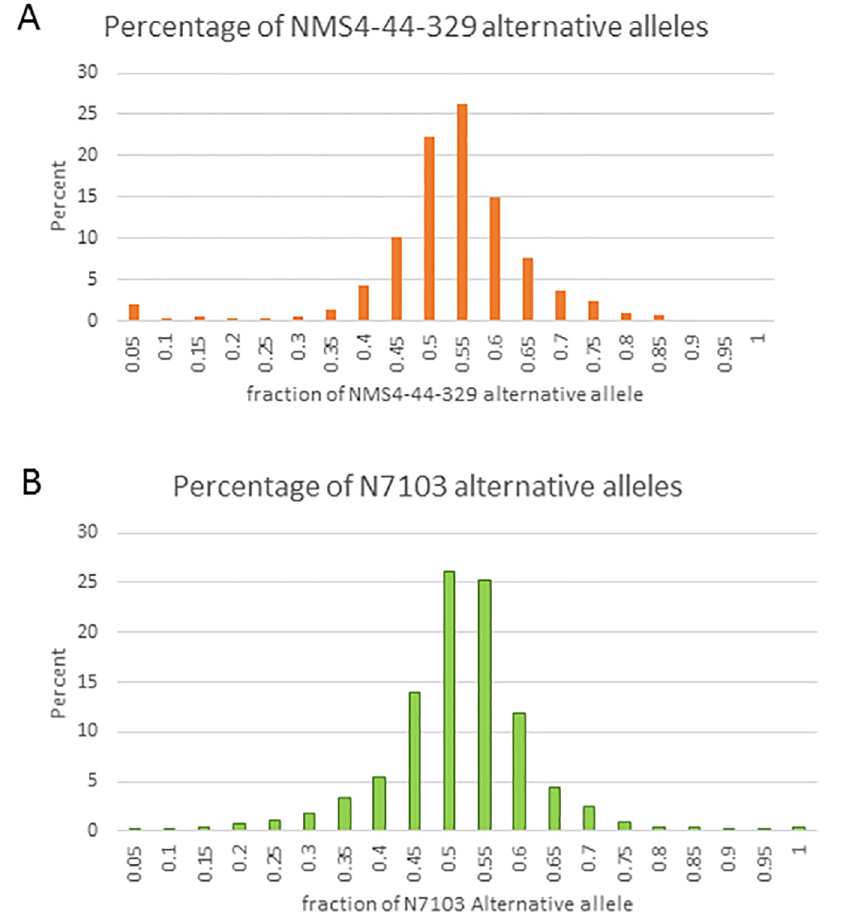
Fig 1. The distribution of the bias of alternative SNPs. The fraction of the alternativealleleis shown as the percent of total SNPS. Panel A shows the alternative allele (relative to the reference genome)from NMS4-44- 329 and Panel B Shows the alternative allelesderived from N7103. Low values ( > 0.5) indicate higherlevels of expressionof the SNP from